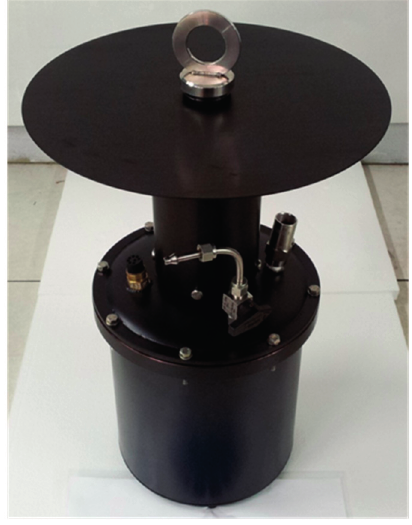
Figure 8. Image of the assembled